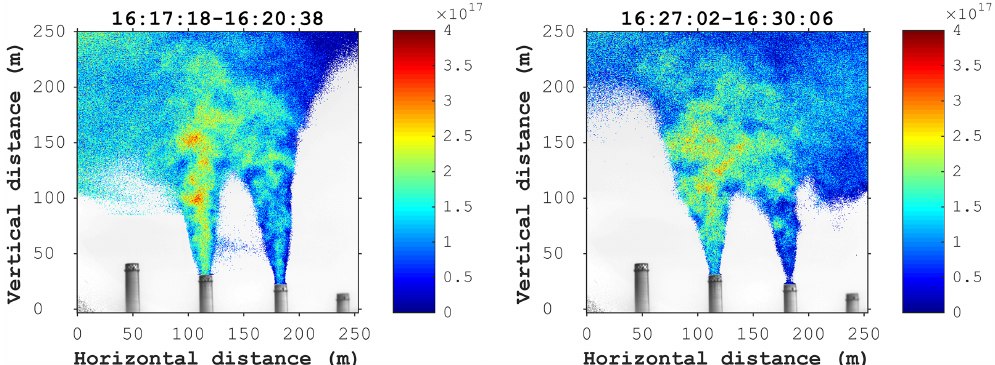
Figure 5. Sample NO 2 SCD field obtained from the averaging of images acquired at λ w2 = 446 . 7nm, λ s2 = 448 . 1nm, λ w4 = 465 . 8nm and λ s4 = 463 . 2nm (12 of each). The color scale shows the plume NO 2 SCD in moleculescm − 2 . The x and y axes show the image dimensions in the scene plane, while the title gives the time span (local